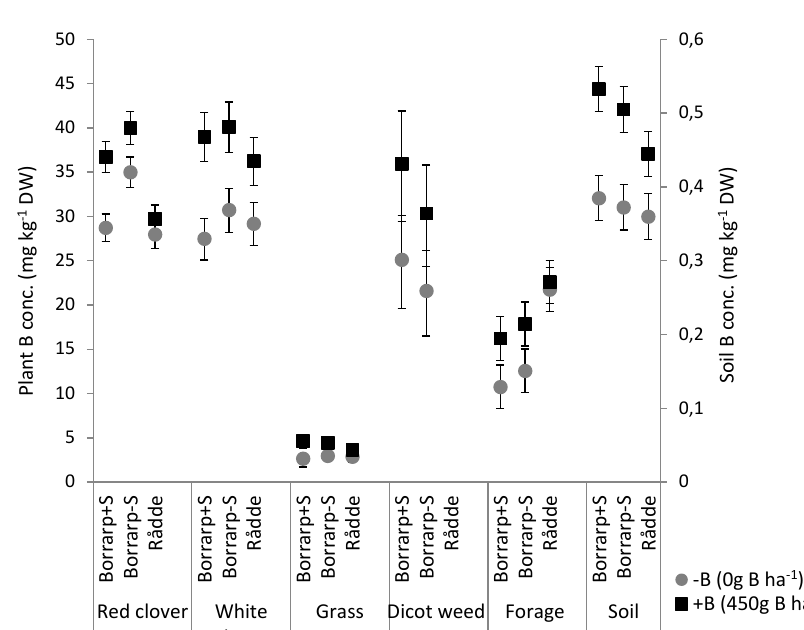
Fig. 1. Effect of boron (B) fertilisation in Borrarp+S (with cattle slurry), Borrarp-S (without cattle slurry) and Rådde on B concentrations in red clover, white clover, grass, dicot weeds, forage mixtures and soil. Error bars indicate 95% confidence intervals.